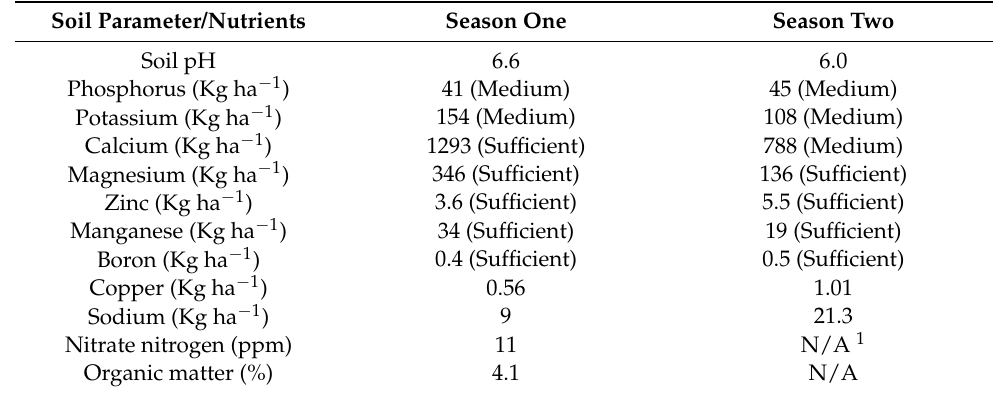
Table 1. Results of soil analysis conducted before planting in season one and season two at the Clemson University Agricultural Service Laboratory, Clemson, SC, USA. The remarks: medium and sufficient indicate soil nutrient status provided in the soil analysis results. Soil Parameter/Nutrients Season One Season Two Soil pH 6.6 6.0 Phosphorus (Kg ha − 1